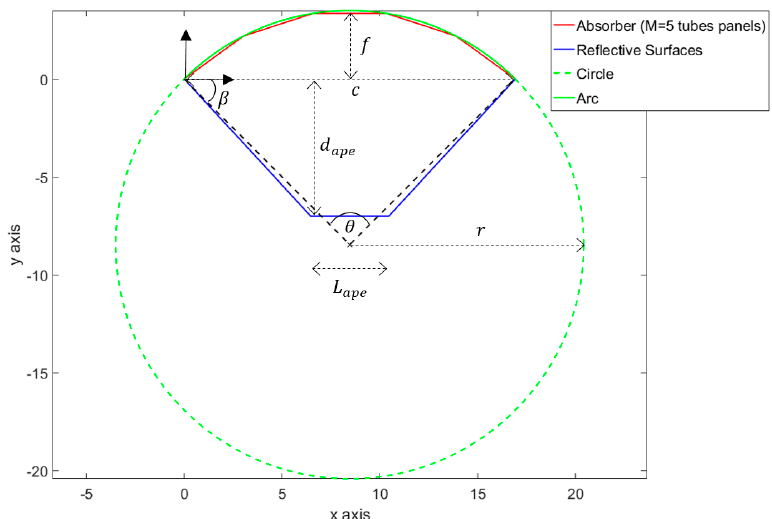
Figure 2. Scheme of a top view of a section of the (x,y) plane of a receiver for the following parameters: the circular arc of radius ≈ 11 m and spanning angle π /2, is discretized in M = 5 segments. The aperture geometry is defined by a length L ape = 4 m and a distance from the absorber d ape = 4